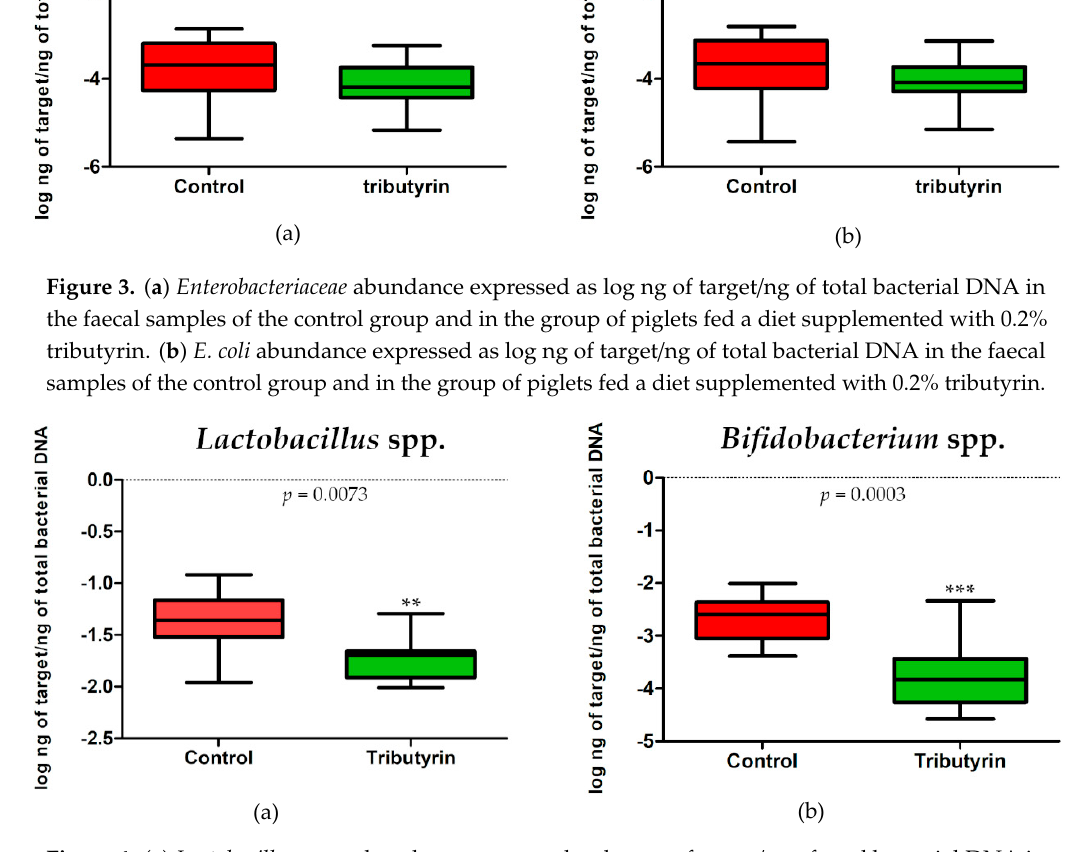
Figure 4. ( a ) Lactobacillus spp. abundance expressed as log ng of target/ng of total bacterial DNA in the faecal samples of the control group and in the group of piglets fed a diet supplemented with 0.2% tributyrin. ( b ) Bifidobacterium spp. abundance expressed as log ng of target/ng of total bacterial DNA in the faecal samples of the control group and in the group of piglets fed a diet supplemented with 0.2% tributyrin.